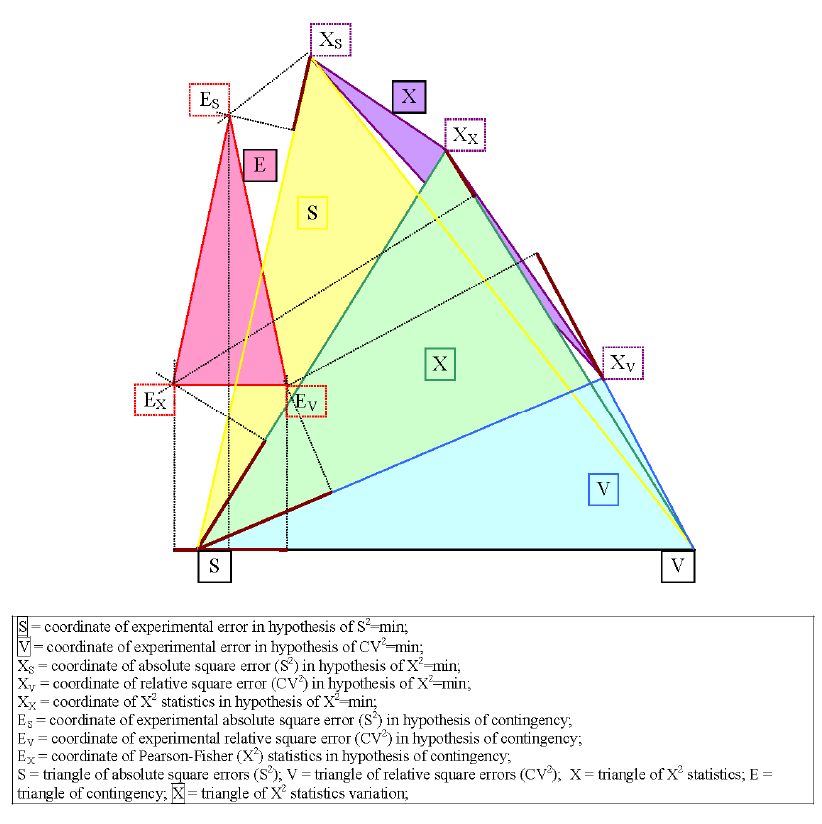
Figure 1. Euclidian distances among estimations of experimental